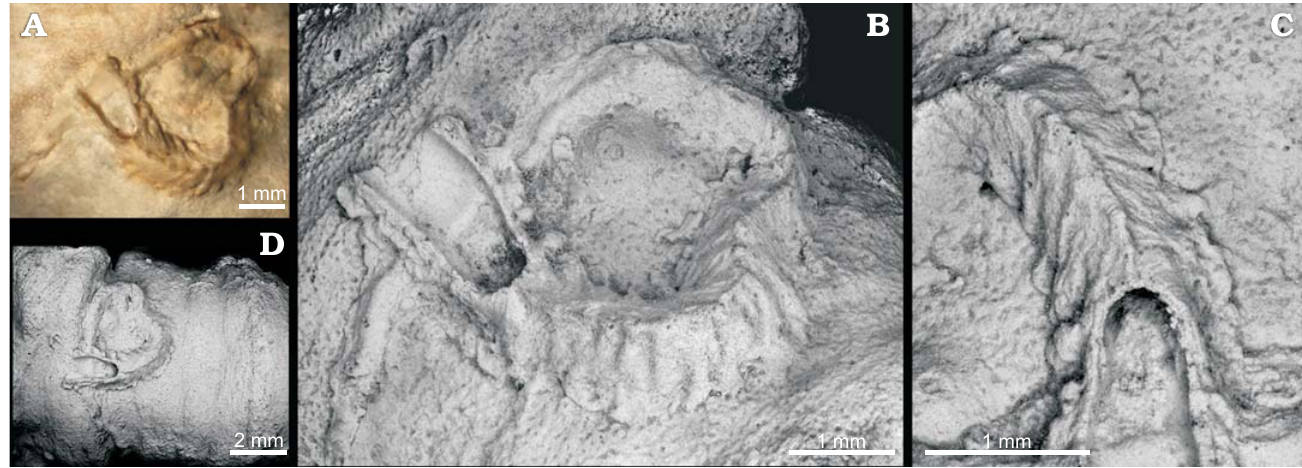
Fig. 4. Serpulid Propomatoceros permianus sp. nov. from the Sosio Valley, western Sicily (Italy), Wordian to upper Permian, holotype MSNC 4526. A . General view of the tube encrusting a sponge. B , C . SEM images, general view ( B ) and detail of the tube ( C ) showing denticles of the median keel and the equally spaced transverse ribs. D . Detail of the median keel bearing inconspicuous